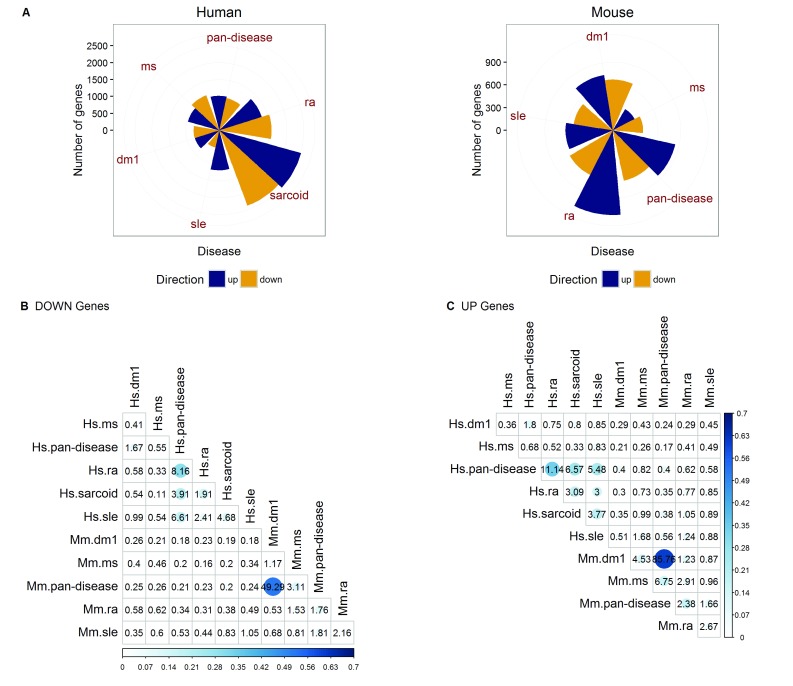
Comparison of differentially expressed genes across diseases in human and mouse.(
A) Number of differentially expressed genes and (
B–
C) the proportion of genes that overlap (i.e. Jaccard index) between UP and DOWN genes (PFP <= 0.05) for pairs of diseases, as indicated by the size and color intensity of the circles. The number in each cell denotes the odds ratio, which is a measure of statistical association between the two groups based on the degree of gene overlap. An odds ratio of 1 suggests no association. Hs = human; Mm = Mouse.